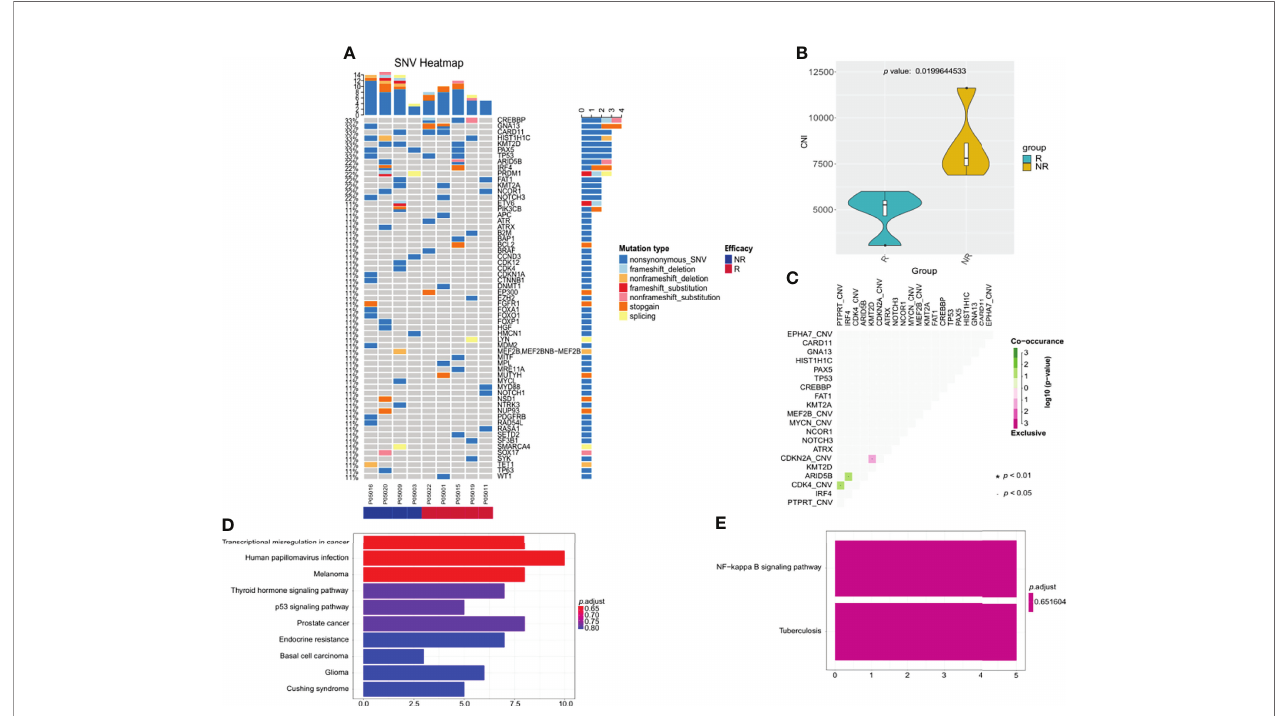
FIGURE 4 | The relationship between clinical response and genetic characteristics in 9 patients treated with orelabrutinib therapy. (A) The gene mutation spectrum. (B) Signi fi cant differences showed between responders and non-responders in copy number instability (CNI), and non-responders had much higher CNI. (C) Analysis of gene co-mutation and mutual exclusion. (D) Gene enrichment analysis of non-responders. (E) Gene enrichment analysis of